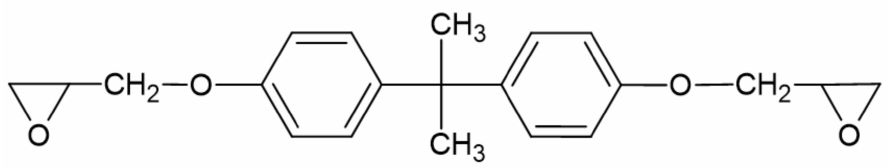
Figure 14. Idealized structure of epoxy resin based on DGEBA [72].